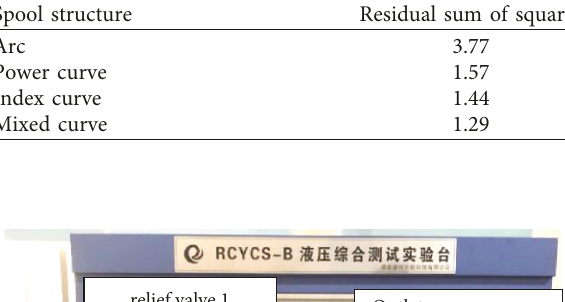
Table 2: Sum of residual squares for flow coefficient ( × 10 − 3 ). Spool structure Residual sum of squares